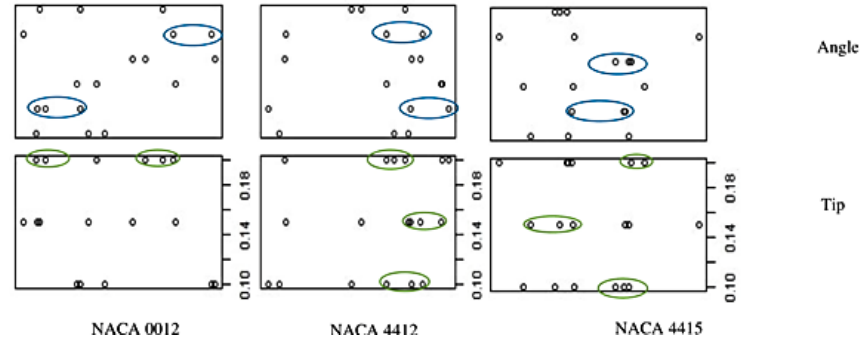
Figure 19. Scatter plot of lift for blade angle and blade tip size of airfoils NACA 0012, NACA 4412, and NACA 4415.